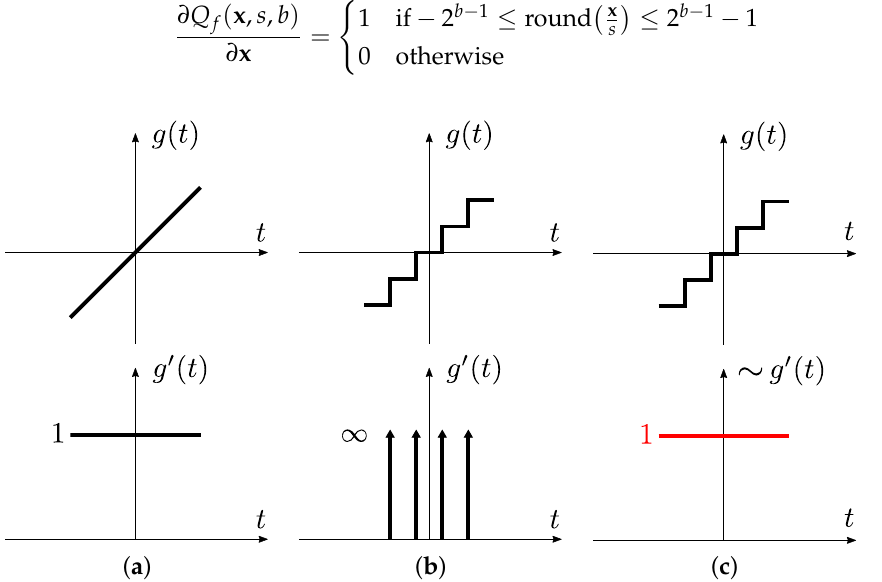
Figure 3. At the top, transfer functions of an identity function ( a ) and a round function ( b ) with their respective derivatives at the bottom. A round function with the STE in the backward pass is depicted in ( c